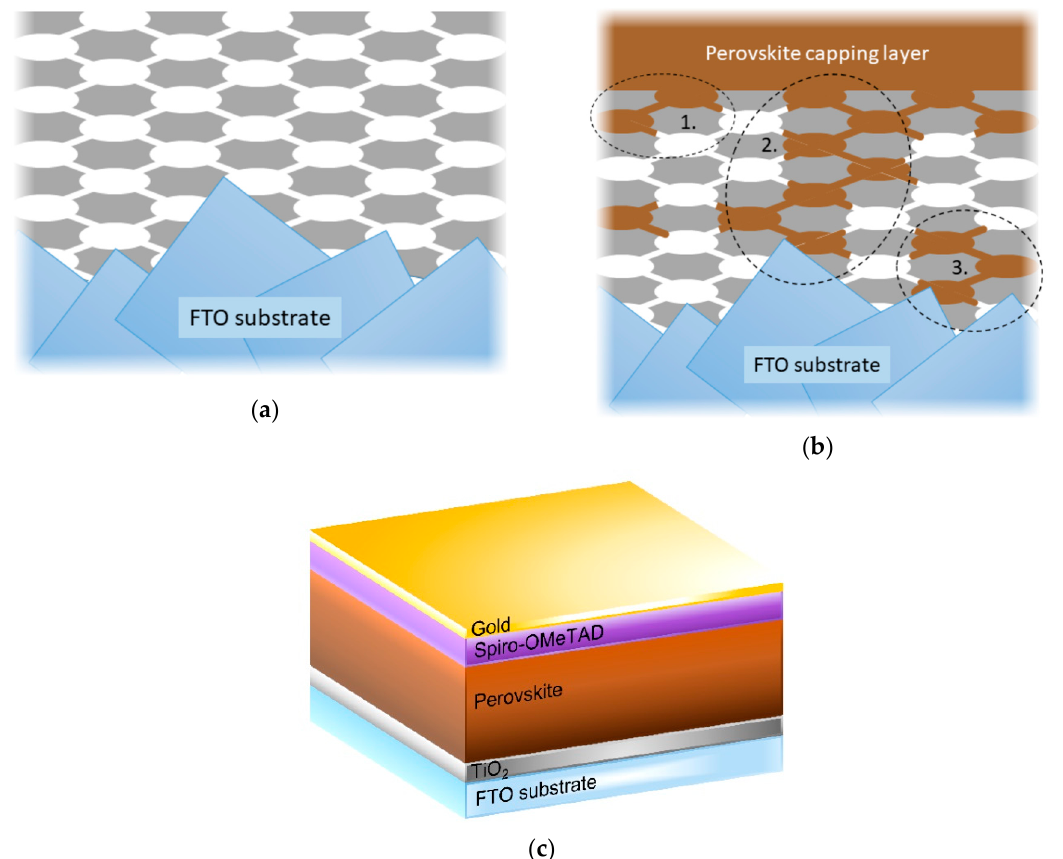
Figure 3. ( a ) A schematic 2-D representation of a porous TiO 2 thin film deposited on top of a rough FTO substrate (note that the dimensions are not to scale); ( b ) suggested pore filling behavior of perovskite inside the porous TiO 2 matrix: 1. Perovskite in contact with the perovskite capping layer, 2. direct perovskite pathway from the capping layer to FTO, and 3. isolated perovskite inside the porous matrix; ( c ) schematic illustration of the investigated device structures, where the TiO 2 ESL is either dense or porous.